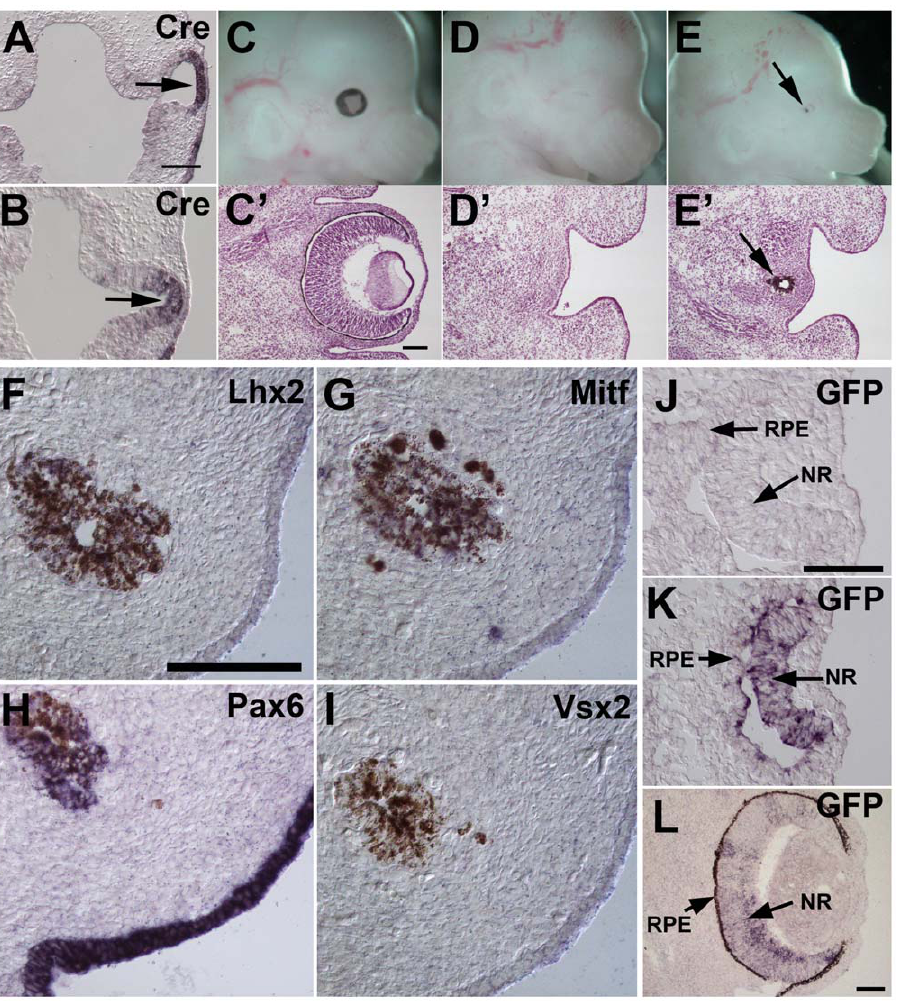
Figure 7. Commitment to the eye-specific progenitor cell is independent of Lhx2 expression. In situ hybridisation analyses of transversal sections reveal Cre expression in the lateral part of the optic vesicle in both control embryos (A) and in Lhx2 2 / 2 embryos (B) at E9.5 (arrows). Lateral view of E14.5 embryos (C–E) and HE staining of transversal sections of the head of the same embryos (C 9 –E 9 ). Eye development is unaffected by transgene expression ( Lhx2-Cre or Z/Lhx2-GFP ) in Lhx2 + / 2 or Lhx2 + / + mice (C,C 9 , an Lhx2-Cre:Lhx2 + / 2 embryo). All embryos with an Lhx2 2 / 2 genotype expressing one of the transgenes ( Lhx2-Cre or Z/Lhx2-GFP ) are anophthalmic (D,D 9 , a Z/Lhx2-GFP:Lhx2 2 / 2 embryo). Expression of Lhx2 in the Lhx2 2 / 2 eye-committed progenitor cells partly rescues eye development since a bilaterally located small mass of pigmented cells appear in all Lhx-Cre:Z/Lhx2- GFP:Lhx2 2 / 2 embryos (E,E 9 , arrows). In situ hybridisation analyses on transversal sections to detect Lhx2 expression (F), Mitf expression (G), Pax6 expression (H) and Vsx2 expression (I) in the pigmented cells that developed in the Lhx-Cre:Z/Lhx2-GFP:Lhx2 2 / 2 embryos. The pigment is brown whereas the in situ hybridisation signal is dark-blue. In situ hybridisation to detect GFP expression and hence confirm transgenic Lhx2 expression in the eye of Lhx-Cre:Z/Lhx2-GFP control double transgenic embryos both at E10.5 (K, Lhx-Cre:Z/Lhx2-GFP:Lhx2 + / + ) and E14.5 (L, Lhx-Cre:Z/Lhx2-GFP: Lhx2 + / + ), whereas GFP is not expressed in Z/Lhx2-GFP single transgenic embryos (J). NR, neural retina. RPE, retinal pigment epithelium. Scale bars: A–B, C 9 –E 9 , F–I, J–L, 100 m